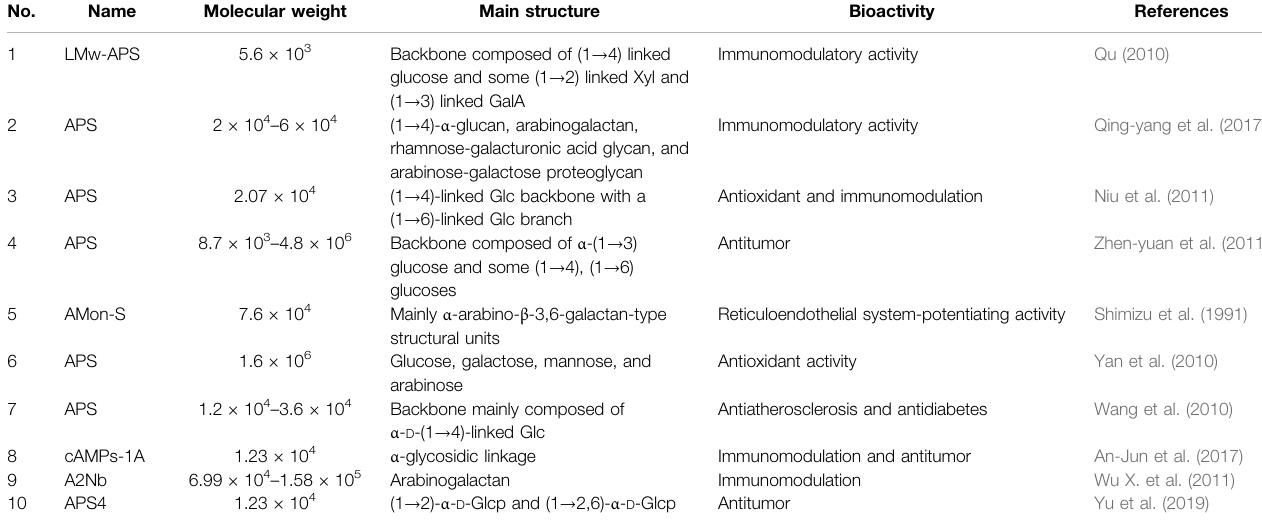
TABLE 1 | Structure characterization of Astragalus polysaccharides